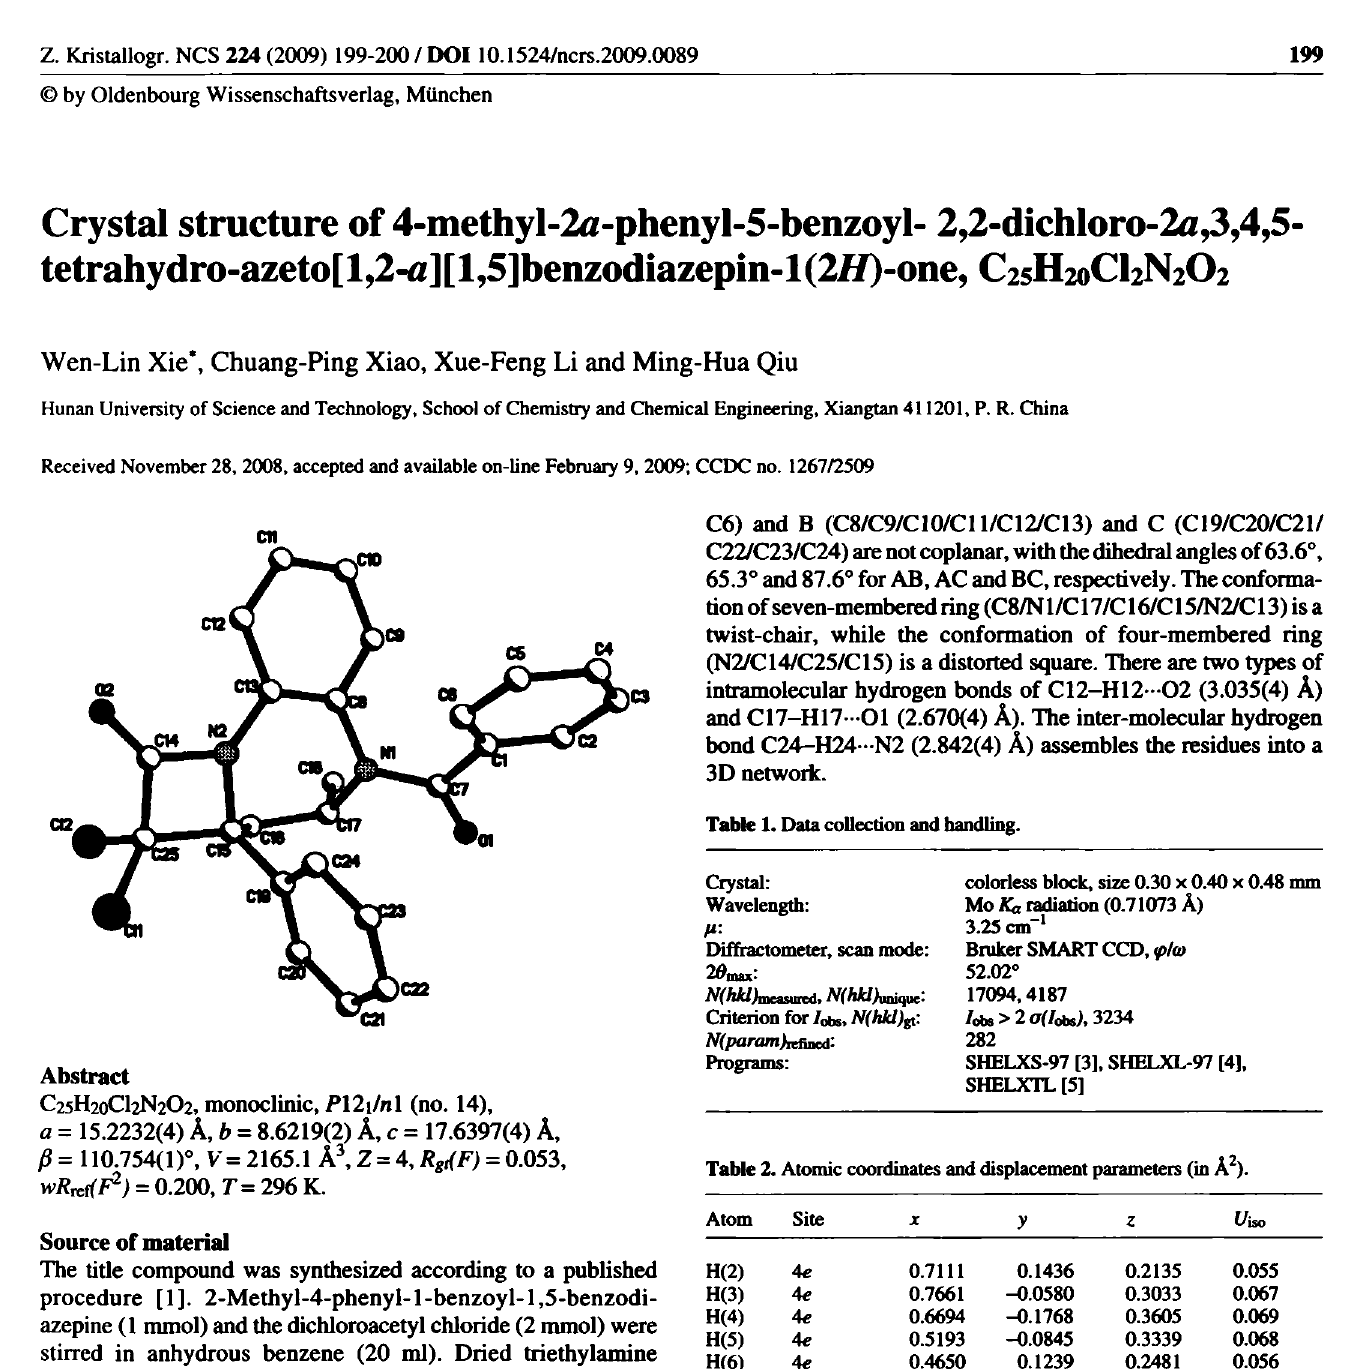
Table 2. Atomic coordinates and displacement parameters (in Â 2